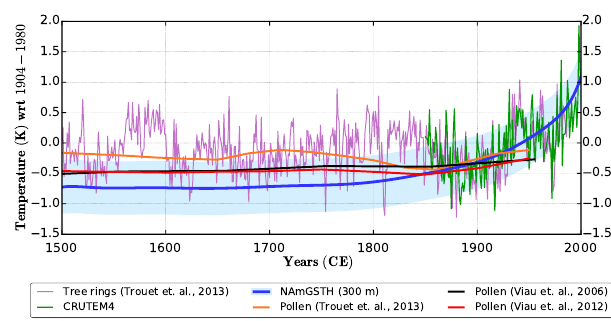
Figure 5. Mean North American GST change (black). Shown in blue are the 510 GST reconstructions inferred from the Monte Carlo inversion.